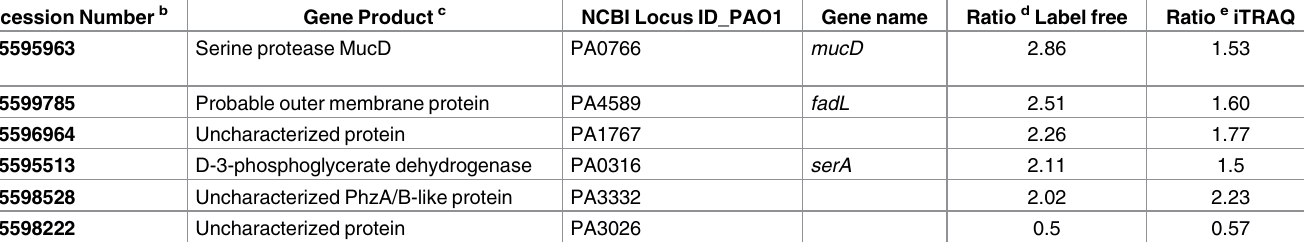
Table 1. Identification of common target proteins differentially expressedduring n- octadecane growth by iTRAQ and label free-based methods a